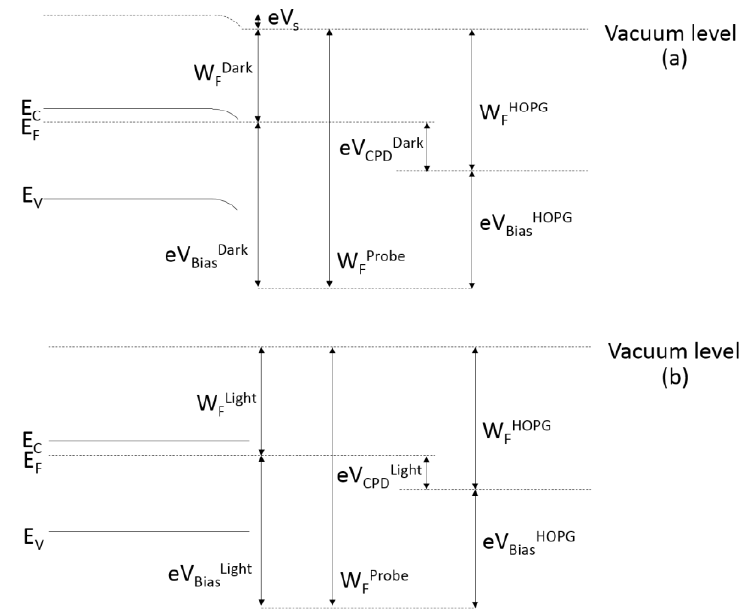
Figure 7. Energy levels measured in a dark Kelvin probe measurement ( a ) and light Kelvin probe measurement in the flat-band condition ( b ).